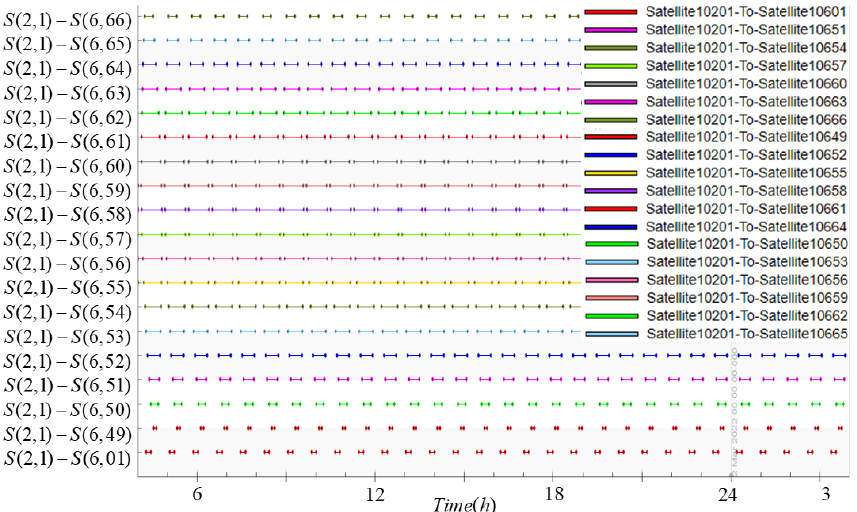
Figure 12. Satellite visibility analysis with more than 3 orbits apart.